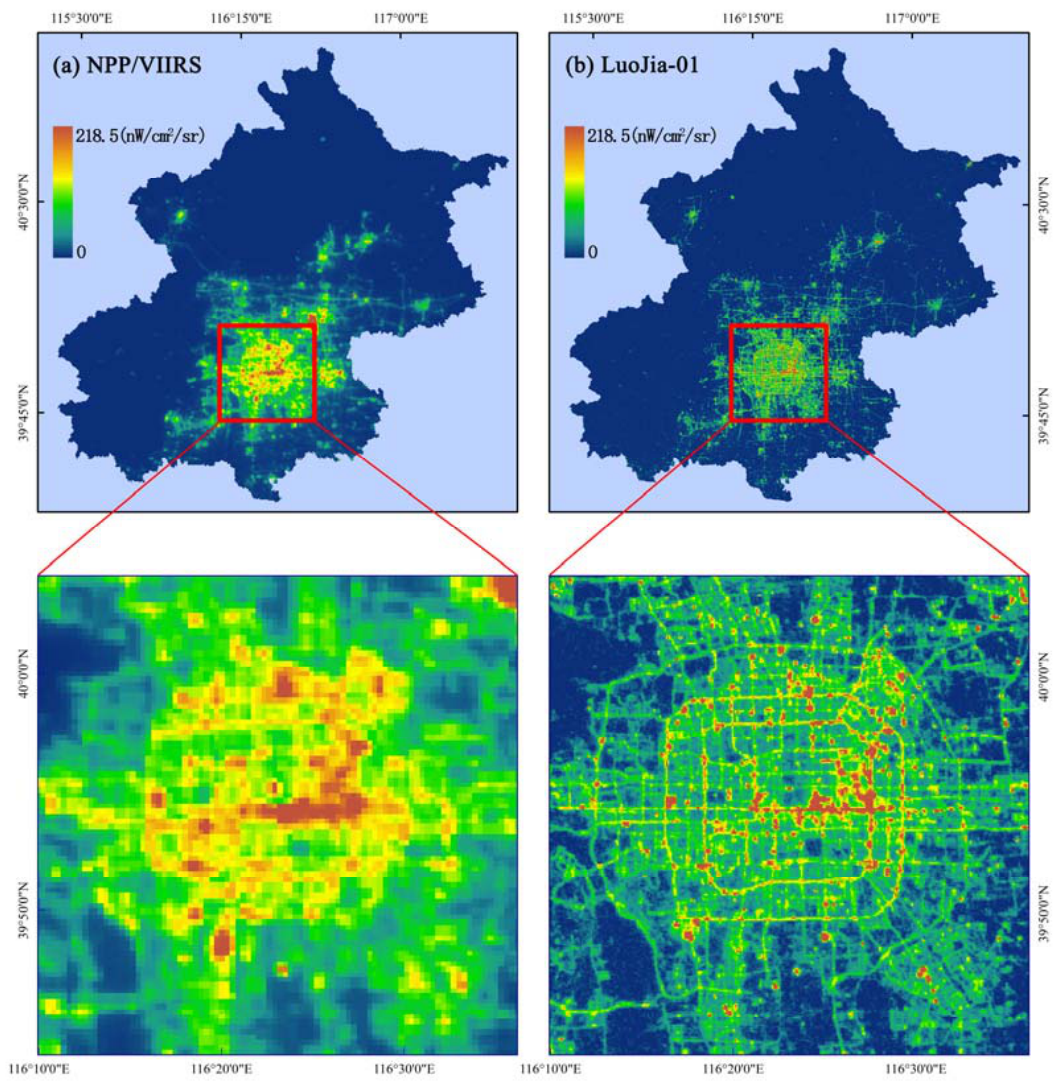
Figure 1. Map of the study areas (zoomed ‐ in Beijing city center, red voxes) and NTL datasets. ( a , b ) Overall spatial distributions of the NPP ‐ VIIRS NTL data (September 2018) and LuoJia1 ‐ 01 NTL data (September 2018).